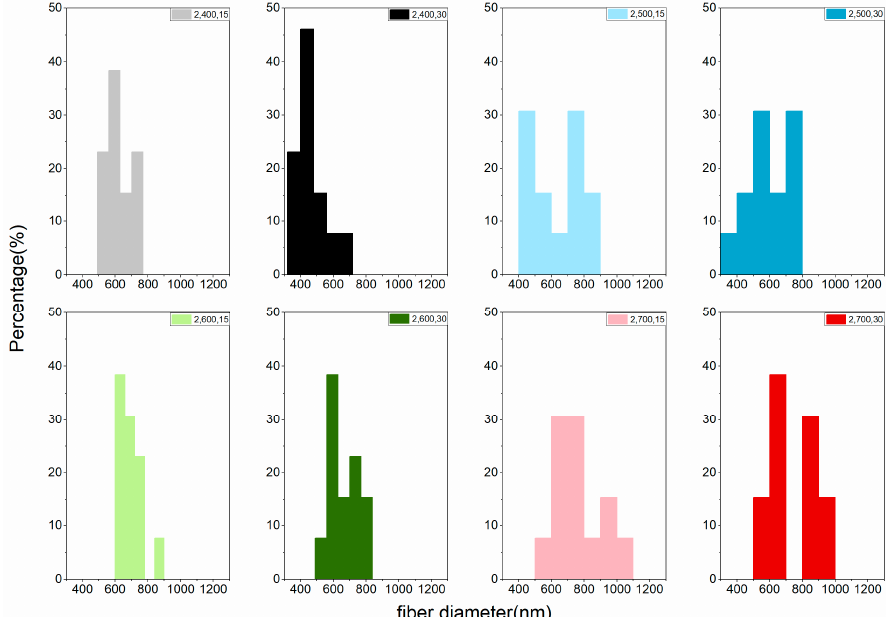
Figure 5. Fiber diameter distribution of the LACFs made with two-step process, for each legend, 2: 2-step; 400–700: carbonization temperature (°C); 15, 30: activation time (min).